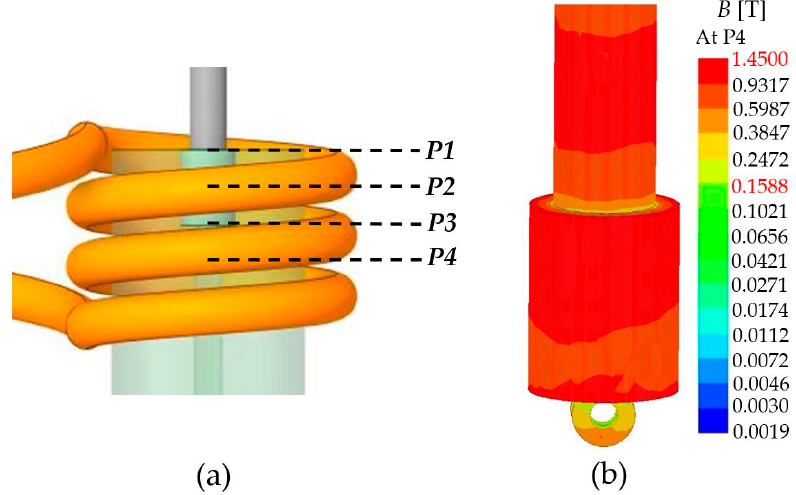
Figure 16. ( a ) Changing positions and ( b ) B around the product at P4 .